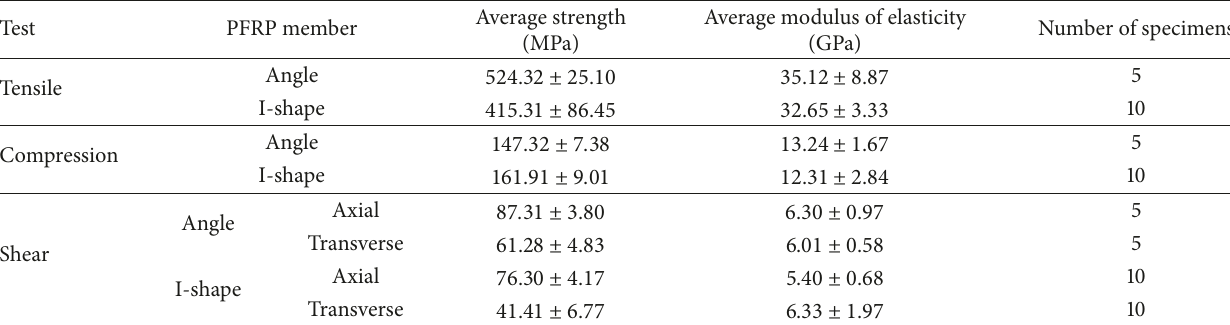
Table 1: Mechanical properties of PFRP